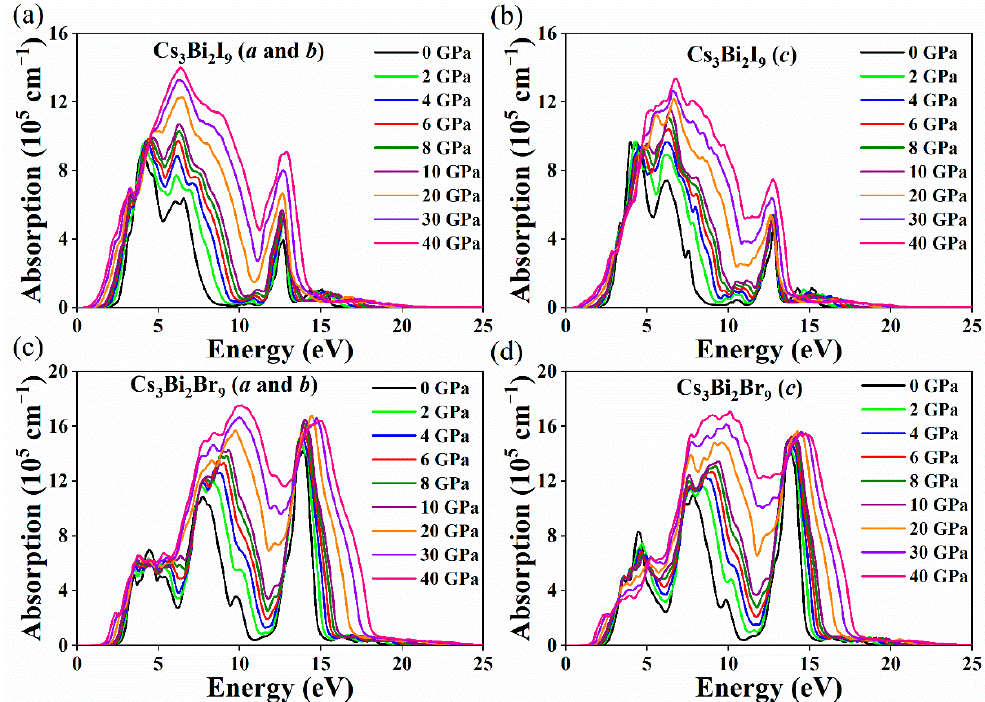
Figure 9. Absorption coefficients of the Cs 3 Bi 2 I 9 along the a - and b -axes ( a ), Cs 3 Bi 2 I 9 along c -axis ( b ), Cs 3 Bi 2 Br 9 along the a - and b -axes ( c ), and Cs 3 Bi 2 Br 9 along the c -axis ( d ) as a function of the pressure (from 0 to 40 GPa).